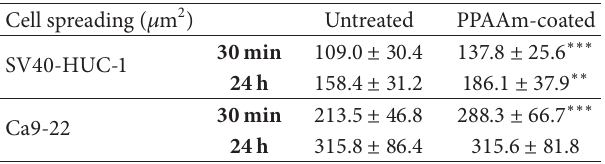
Table 2: Cell spreading of SV40-HUC-1 uroepithelial cells and Ca9- 22 gingiva cells on untreated and PPAAm-coated PLA meshes